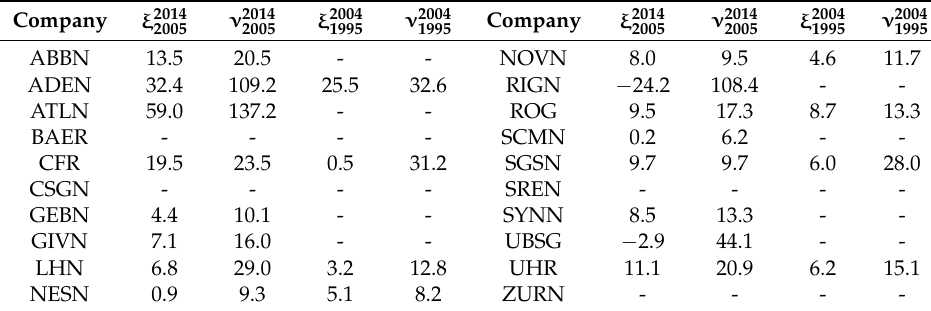
Table A8. Estimated parameters ξ ( % ) and ν ( % ) , for each company of SMI index. Company